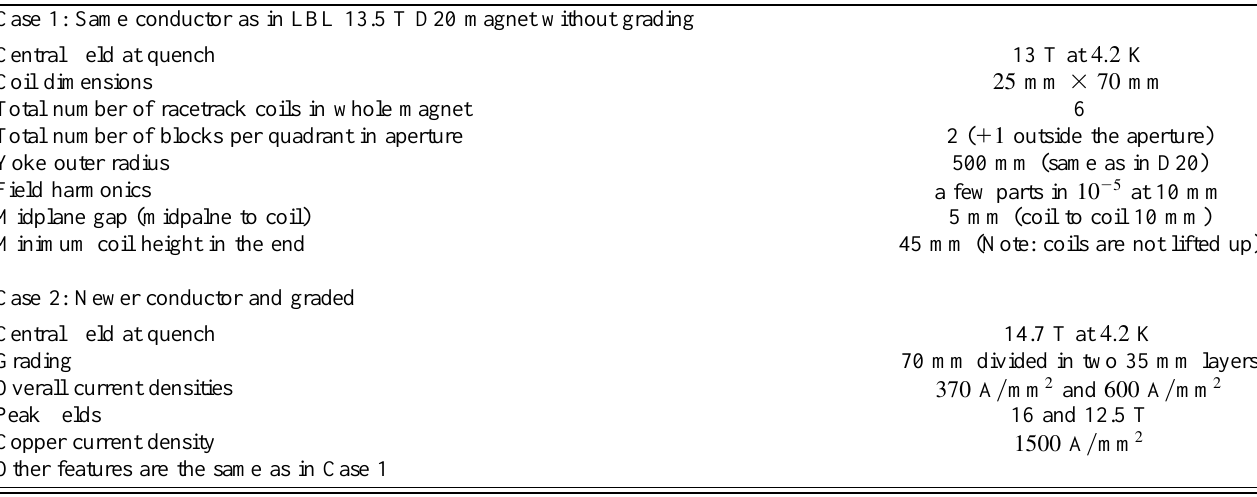
TABLE XIII. Preliminary design parameters for a racetrack Nb 3 Sn dipole with two different types of cable. Case 1: Same conductor as in LBL 13.5 T D20 magnet without